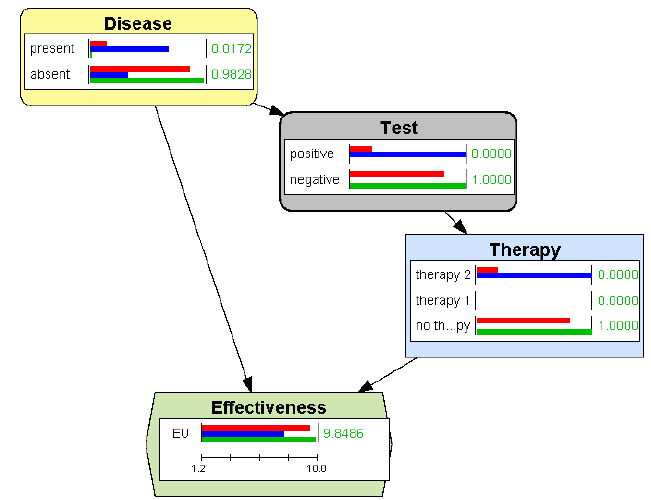
Figure 6. An influence diagram (ID) for deciding the optimal therapy based on the result of a test. The red bars represent the probabilities and the utility when no finding is introduced, i.e., the values for the general population. The blue and green bars correspond to a positive and a negative test result respectively.